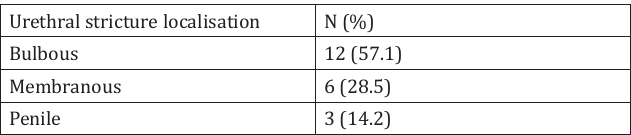
Urethral stricture localisation N